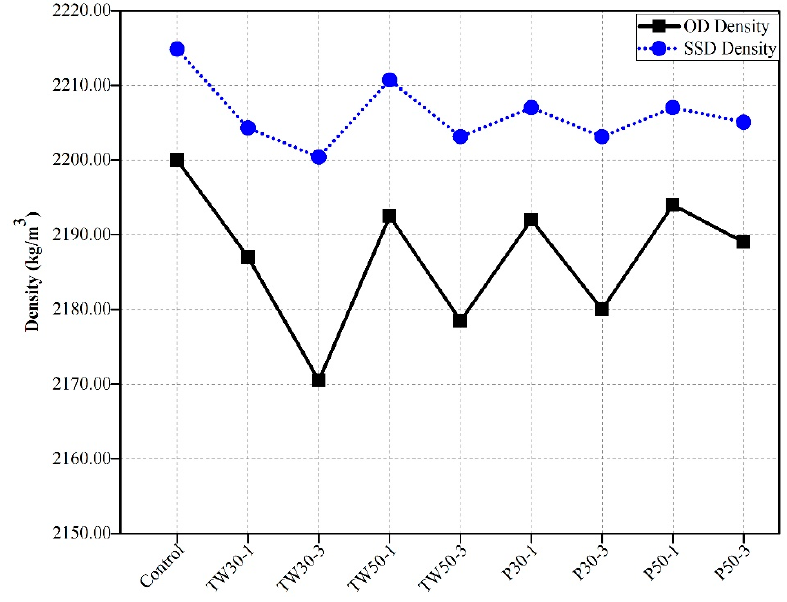
Figure 5. Oven dry and saturated surface dry densities of specimens.